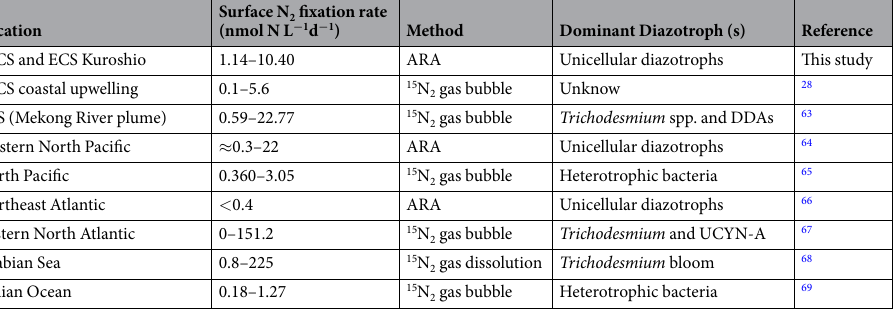
Table 3. Surface N 2 fixation rates and dominant diazotroph (s) of different Oceanic Region. ARA = acetylene reduction assay.